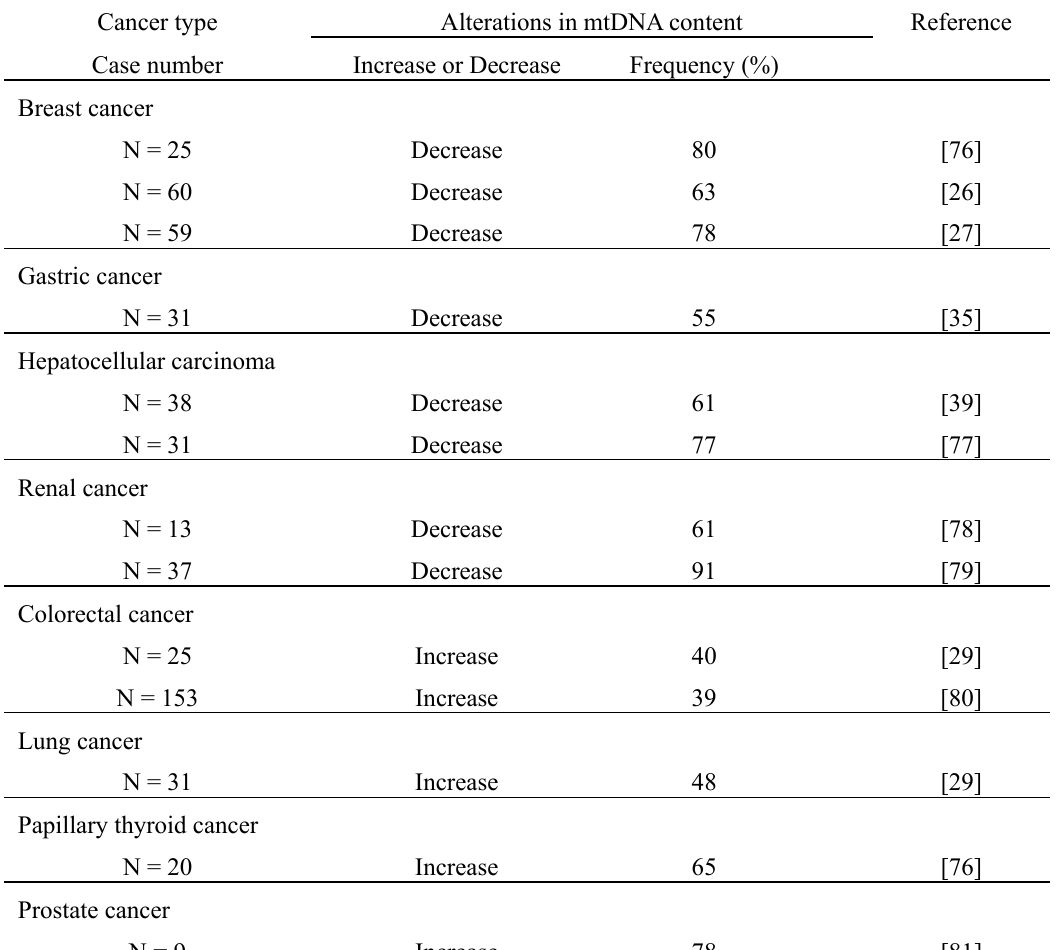
Table 4. Alterations in mtDNA content of human